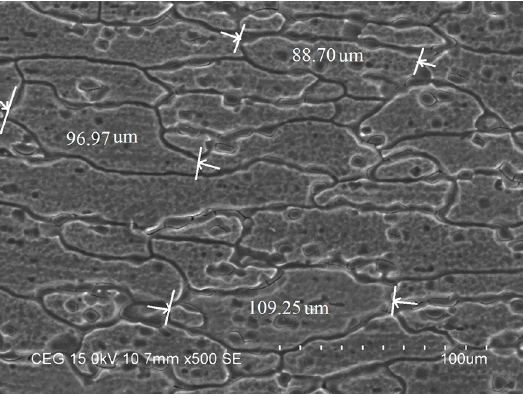
Figure 11 . Microstructures of the parent metal